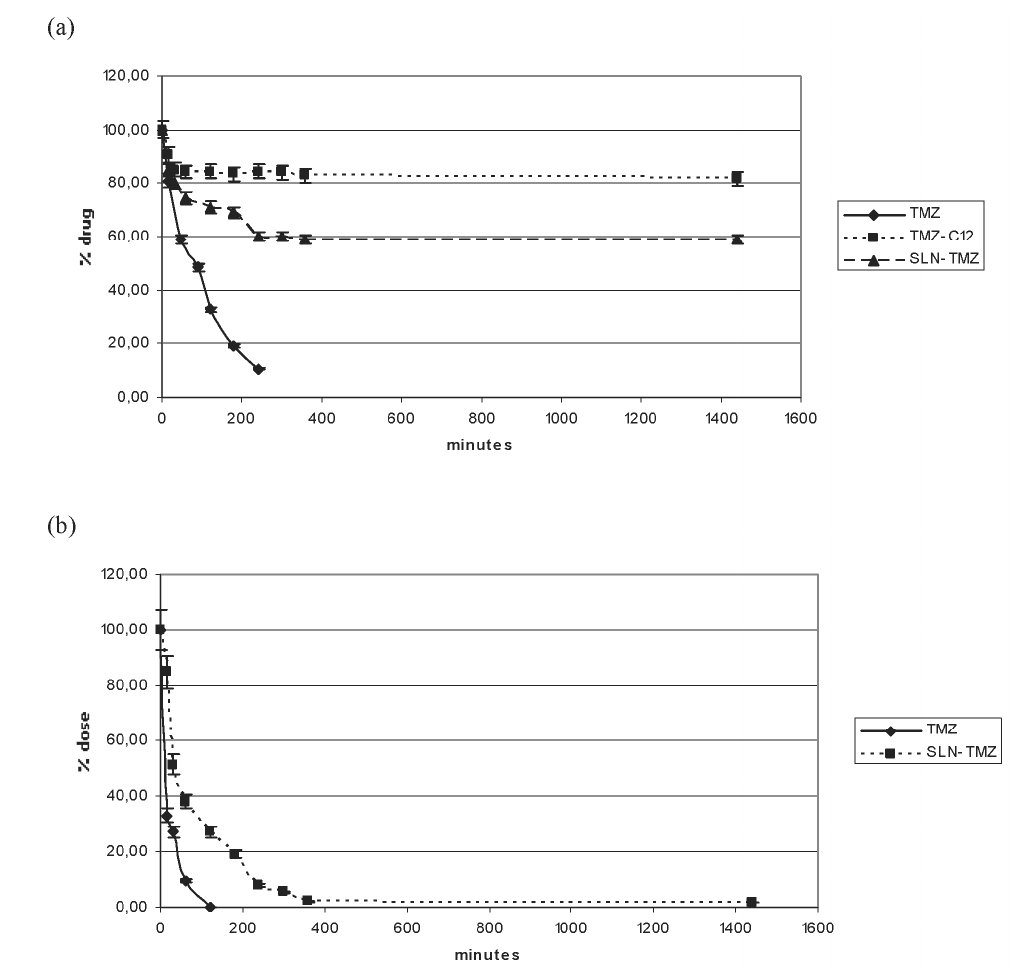
Figure 4. Stability of formulations in RPMI 1640 and in plasma. ( a ) Stability in RPMI 1640 of free TMZ, TMZ-C12 and SLN-TMZ; ( b ) Stability in plasma of free TMZ and SLN-TMZ. Error bar means SEM.